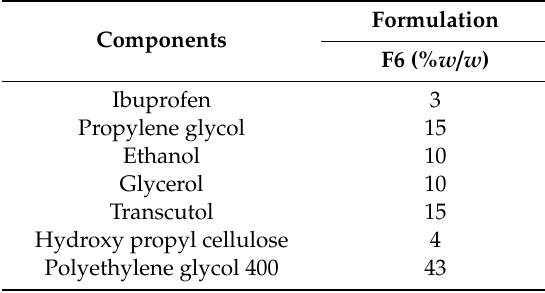
Table 3. Composition of optimized clear non-aqueous gel in the